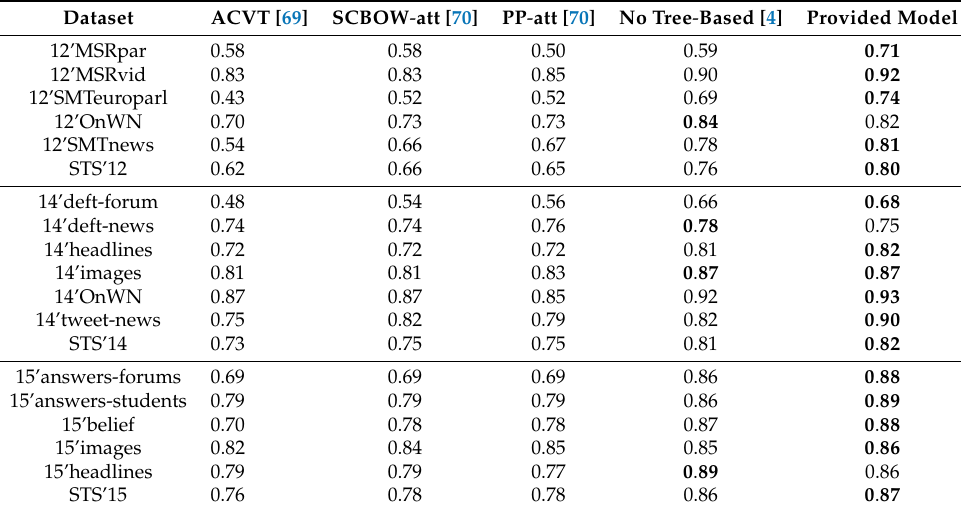
Table 4. Comparison of the Pearson correlation coefficient (Pcc) in each dataset. Dataset